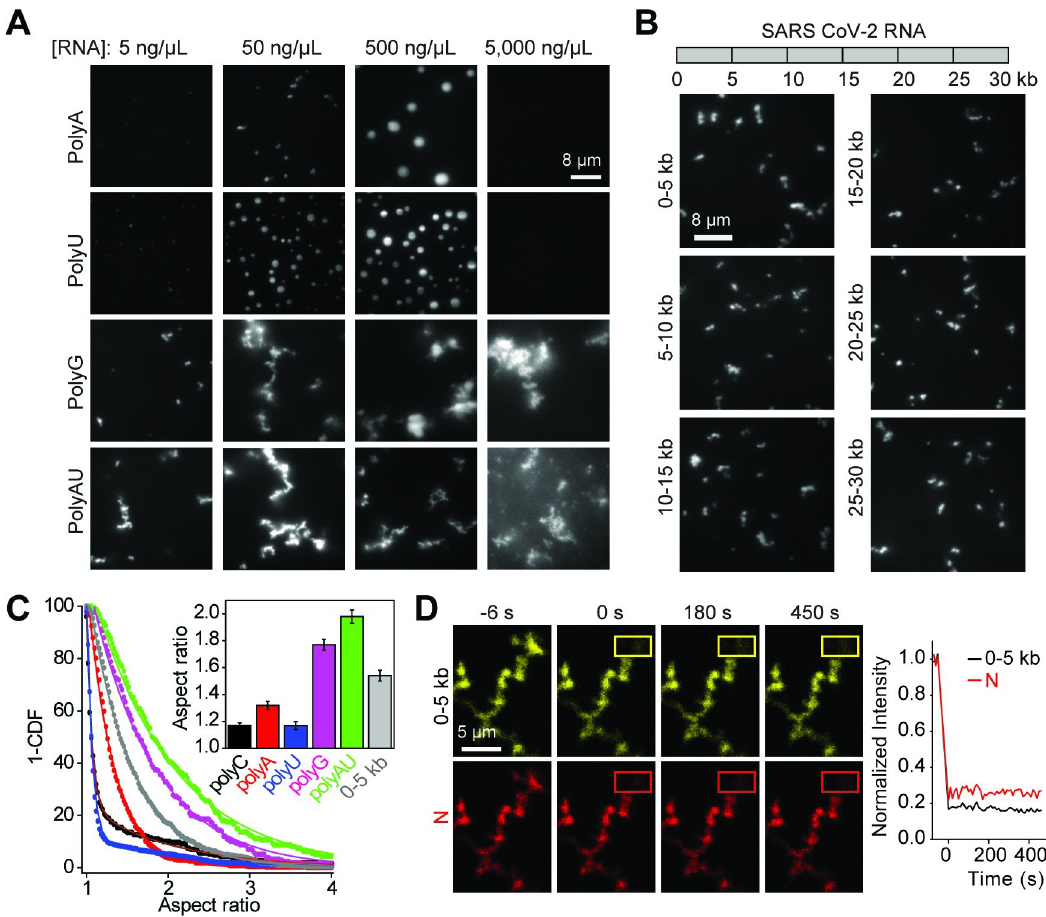
Fig 2. The N protein forms asymmetric condensates with viral RNA. (A) The N protein forms spherical condensates with polyA and polyU RNA but forms asymmetric condensates with substrates that form Hoogsteen (polyG) and Watson–Crick (polyAU) base pairing interactions. The N protein concentration was set to 18.5 μ M. (B) (Top) SARS-CoV-2 genomic RNA was divided into six 5-kb sections. (Bottom) The formation of asymmetric N condensates in the presence of 18 nM RNA. The N protein concentration was set to 18.5 μ M. (C) The inverse cumulative distribution (1-CDF) of the aspect ratio of individual N condensates formed with different RNA substrates. The concentrations of N protein, RNA homopolymers, and 0-5 kb viral RNA were set to 18.5 μ M, 50 ng/ μ L, and 18 nM, respectively. Solid curves represent a fit to exponential decay. (Insert) Decay constants of the exponential fits ( ± SE). (D) (Left) Representative FRAP imaging of an N and 0-5 kb viral RNA condensate. The image of a condensate before the time of photobleaching (0 second) shows colocalization of Cy3-labeled 0-5 kb viral RNA and LD655-N in the condensate. Rectangles show the photobleached area. (Right) N and 0-5 kb viral RNA do not exhibit fluorescence recovery in the bleached region ( n = 16). Data underlying this figure can be found in S1 Data. CDF, cumulative distribution function; N, nucleocapsid; SARS-CoV-2, Severe Acute Respiratory Syndrome Coronavirus 2.